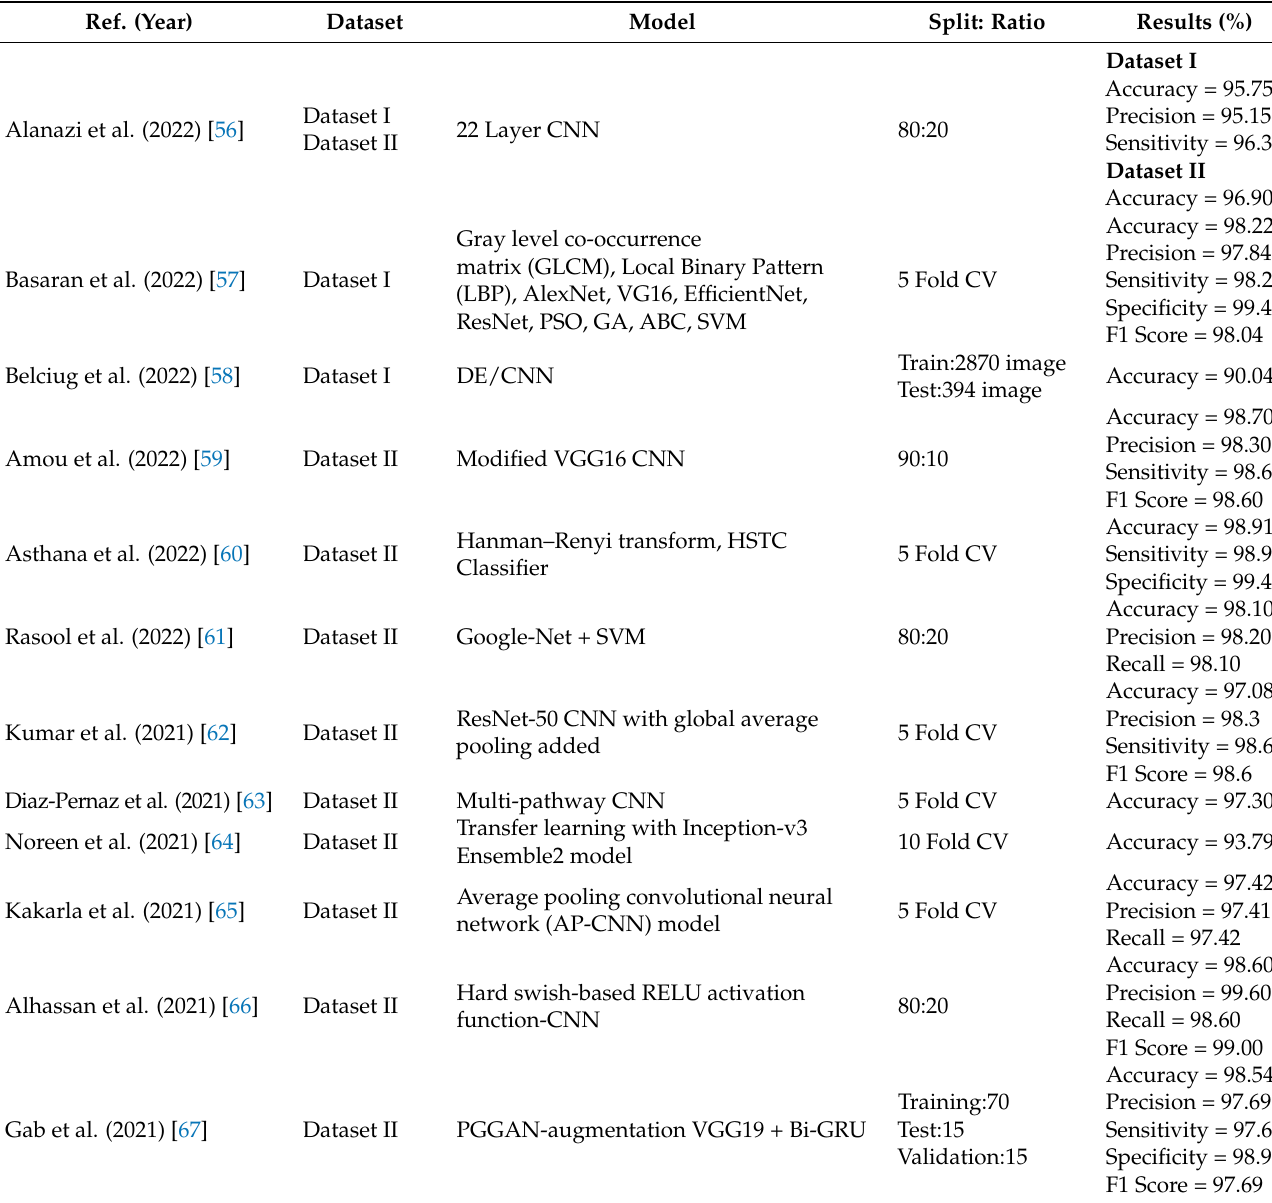
Table 5. Comparison of results with the state-of-the-art